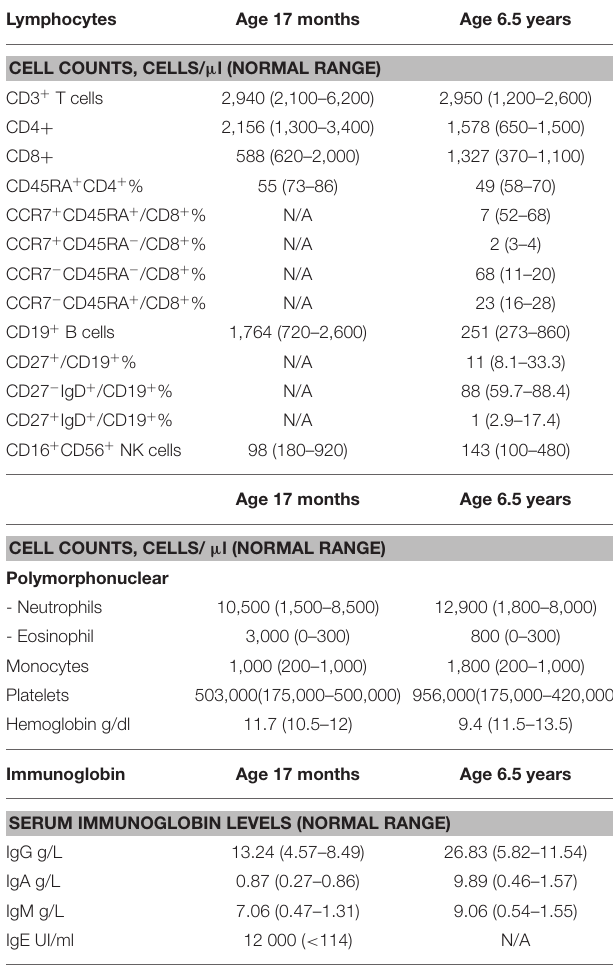
TABLE 1 | Immunological phenotypes of TTC7A patient carrying R325Q homozygous mutation.